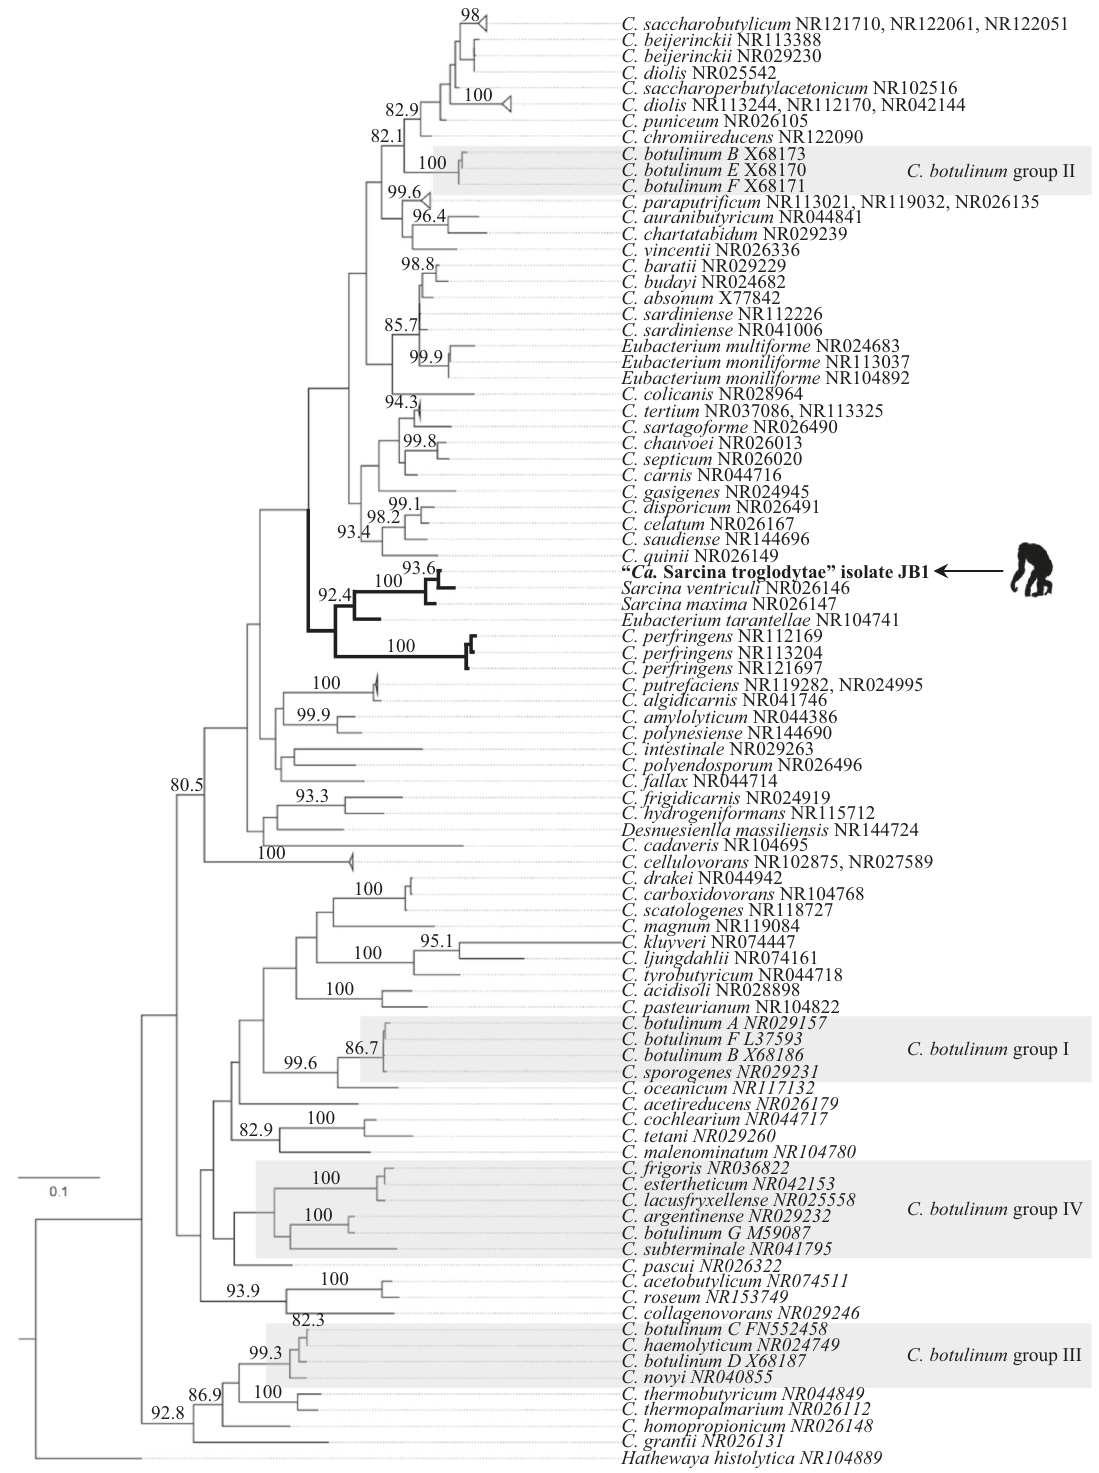
Fig. 7 Maximum-likelihood 16S rDNA gene phylogeny of the Clostridiaceae . The phylogeny is based on the complete 16S rDNA sequence of “ Ca . Sarcina troglodytae ” isolate JB1 (arrow and silhouette) and 98 other Clostridia sensu stricto , with Hathewaya histolytica as the outgroup. Gray boxes indicate Clostridium botulinum groups 62 . Numbers above the branches are bootstrap values (%) based on 1000 bootstrap replicates (only values ≥ 75% are shown). Scale bar indicates nucleotide substitutions per